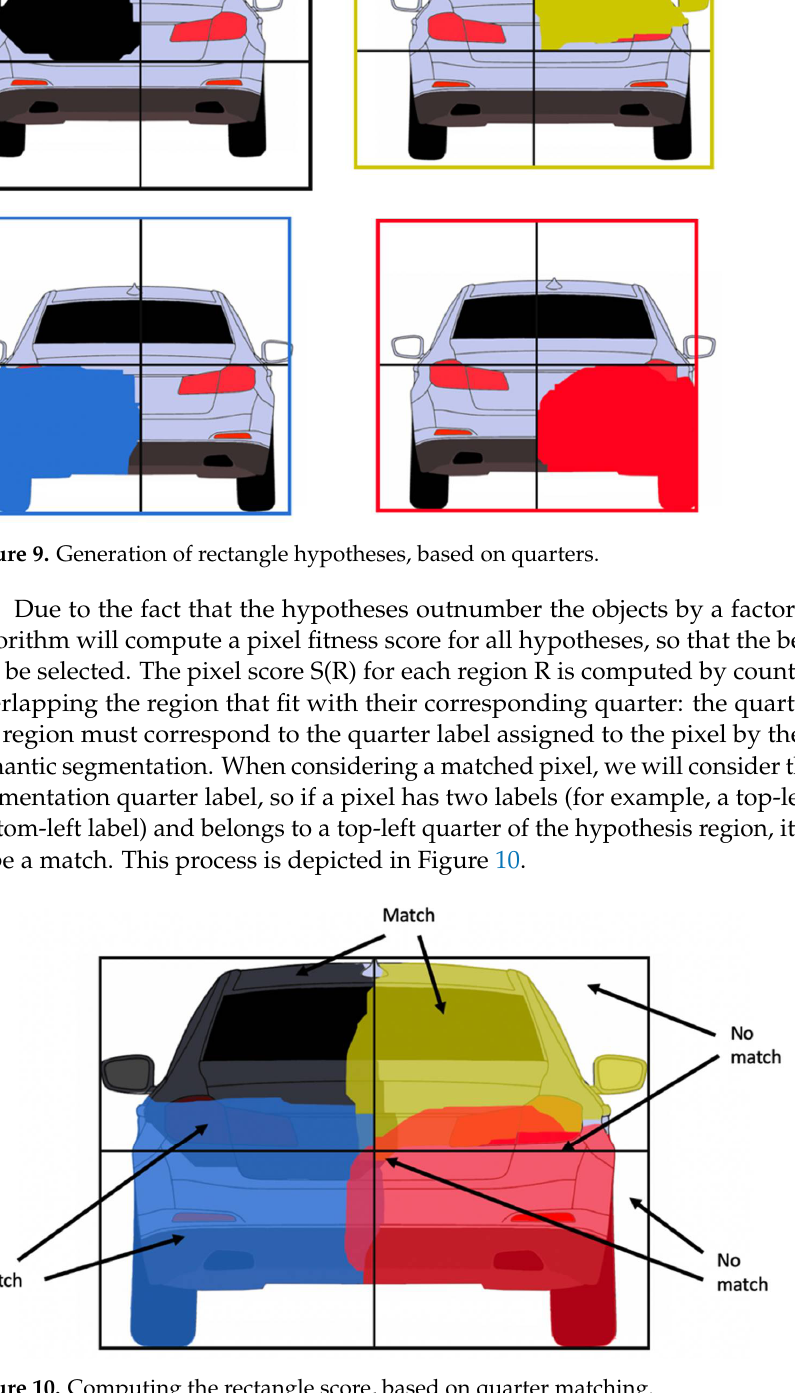
Figure 10. Computing the rectangle score, based on quarter matching.